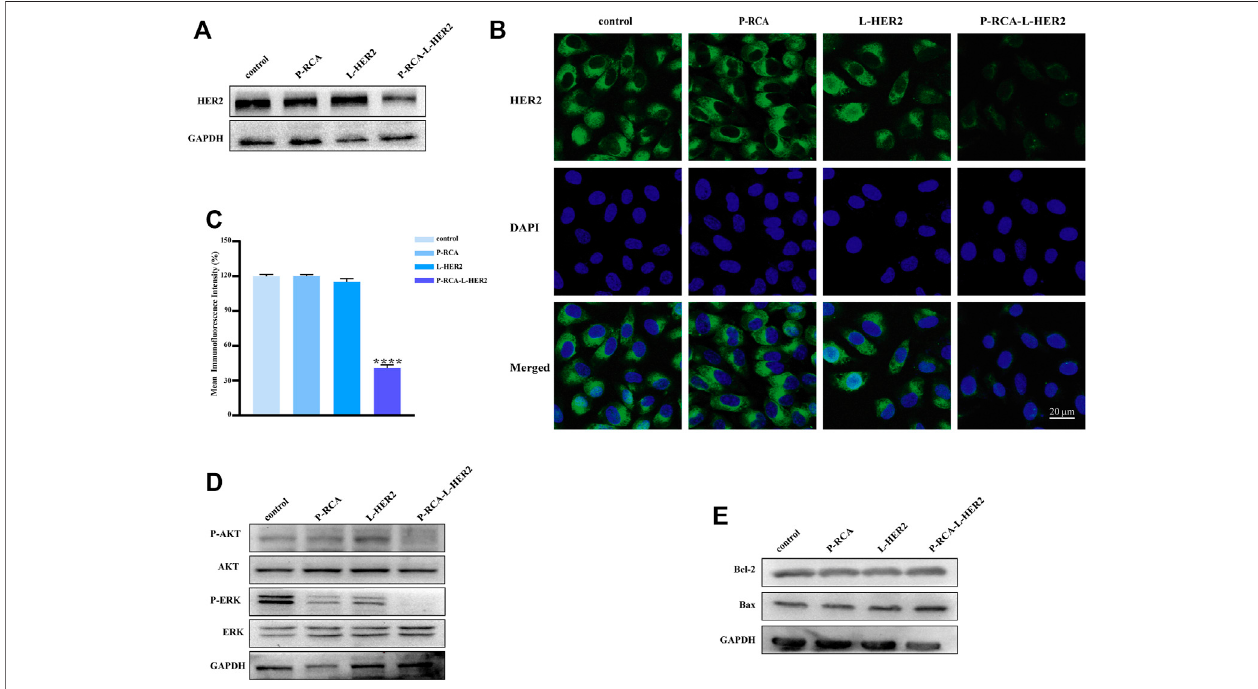
FIGURE 3 | Effects of HER2 aptamer-decorated DNA hydrogel on SK-BR-3 cells. (A) Western blotting and (B) immuno fl uorescence of the HER2 protein expression changer of SK-BR-3 cells treated with P-RCA, L-HER2, or P-RCA-L-HER2 for 48 h. Scale bar: 20 μ m. (C) Quantitative analysis of mean fl uorescence intensity of HER2 protein. (D, E) Western blotting of the downstream pathway protein of HER2 and apoptosis-related protein expression changes of SK-BR-3 cells treated with P-RCA, L-HER2, or P-RCA-L-HER2 for 48 h. Error bars denote standard deviations from three independent experiments. Statistical analysis: **** p < 0.0001 vs. control.